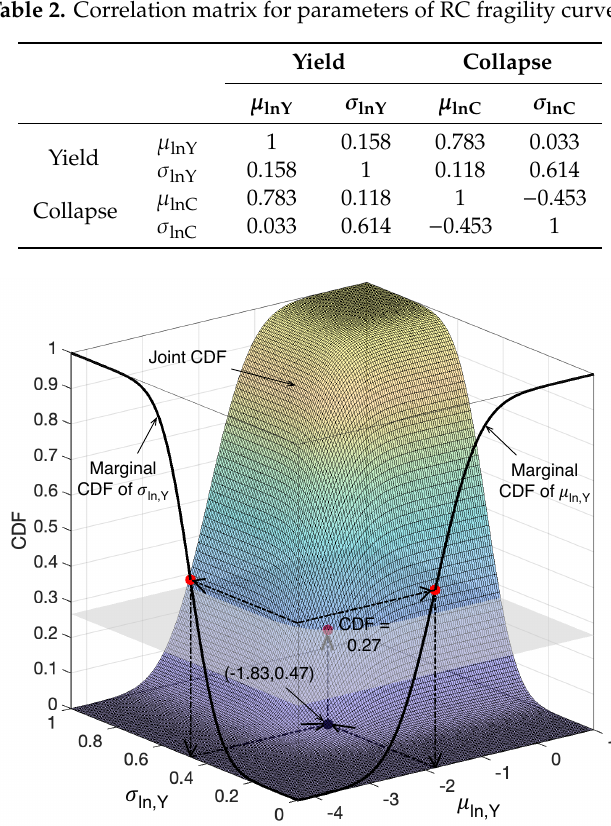
Figure 1. Example showing the derivation of the fractile (black dot) of the joint distribution corresponding to the 50% fractile of the two fragility parameters, according to the approach proposed in